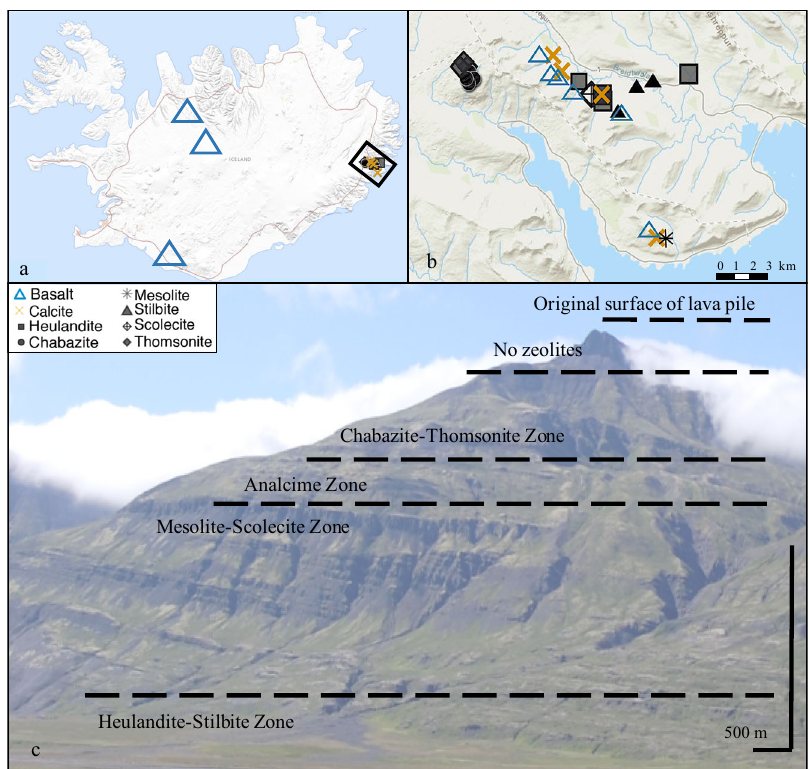
Fig. 1 Map of Iceland showing sample locations. a Mineral separates were obtained from basalts sampled throughout Iceland. The Berufjörður – Breiðdalur region of East Iceland is outlined. b Sampling locations of bulk rocks, calcite, and zeolites collected from the main region of study. c Zeolite sampling locations correspond to different elevations or depths below the original surface of the lava pile. Depth-controlled zeolite zones, adapted from Walker (1960), are overlain on a photograph of the Berufjörður volcanic sequence taken from the north.